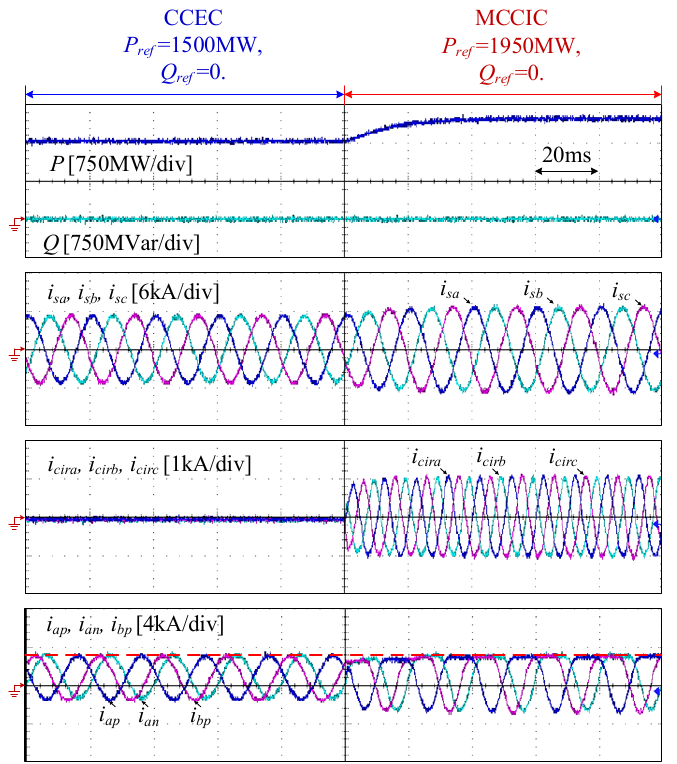
Figure 14. Experimental waveforms of the overload performance of the MMC using the proposed Figure strategy.